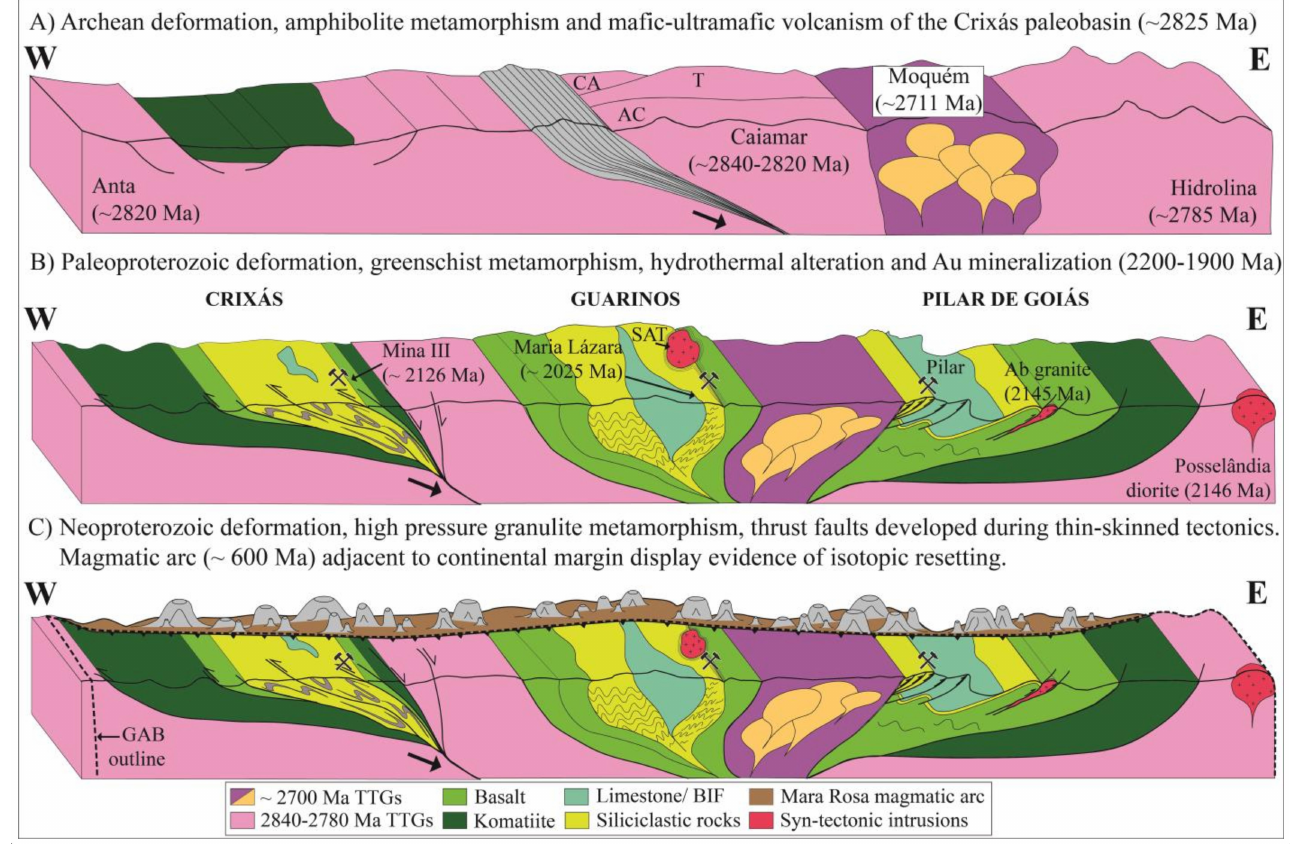
Figure 7. Schematic block diagrams showing the evolution of the northern GAB during ( A ) Archean event, ( B ) Paleoprotero- zoic event, and ( C ) Neoproterozoic event (not to scale). Abbreviations in A for the Caiamar TTG terrane refer to Crix á s-Açu (CA), Tocambira (T), and Á guas Claras